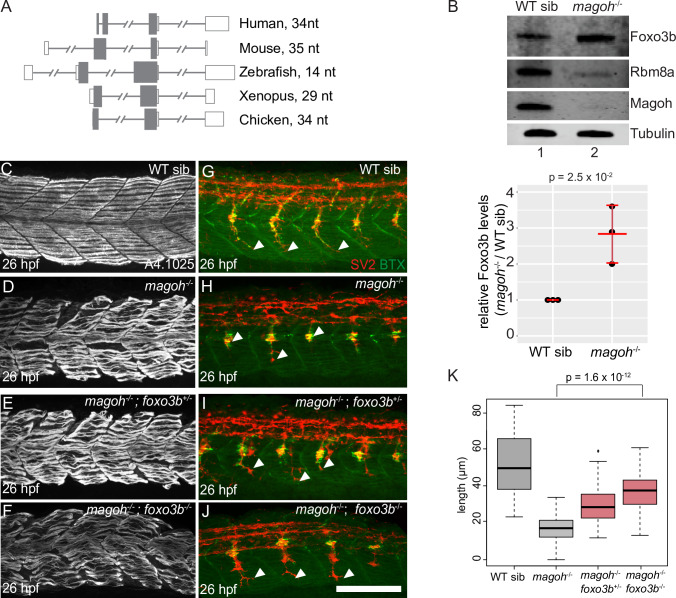
Partial or complete loss of foxo3b in magoh mutant embryos rescues motor neuron outgrowth defects.A. Illustration showing foxo3b gene structure in indicated vertebrates. The distance between the stop codon and the proximal 3′UTR intron is on the right. Open rectangles: UTRs, filled rectangles: coding region, gray lines: introns (hash marks denote shortened intron sequences). B. Top: Western blot showing protein levels in wild-type sibling (lane 1) and magoh mutant (lane 2) embryos at 21 hpf. Bottom: a dot plot showing Foxo3b levels normalized to tubulin levels in magoh mutant embryos and WT siblings at 21 hpf in three biological replicates. (N = 5 embryos per genotype per replicate). Error bars: standard error of means. C-F. Confocal images showing Myh1 immunofluorescence using anti-A4.1025 in somites 12–16 of WT sibling (C), magoh-/- mutant (D), magoh-/-; foxo3b+/- mutant (E), and magoh-/-; foxo3b-/- mutant (F) embryos at 26 hpf (N = 13 embryos/genotype). G-J. Merged confocal images showing motor neurons (red; detected by anti-SV2 staining) and acetylcholine receptors (green; detected by alpha-bungarotoxin staining) in somites 12–16 of WT sibling (G), magoh-/- mutant (H), magoh-/-; foxo3b+/- mutant (I), and magoh-/-; foxo3b-/- mutant (J) embryos. Neuromuscular junctions in the merged images are yellow. White arrowheads point to the distal end of the motor neuron. (N = 13 embryos per genotype). Scalebar in J (for panels C-J) is 100 nm. K. Boxplots showing quantification of motor axon length in embryos of genotypes indicated along the x-axis (4 motor neurons/embryo and 13 embryos/genotype). Welch’s t-test p-values for comparison between magoh-/- mutant and magoh-/-; foxo3b-/- mutant embryos are at the top.